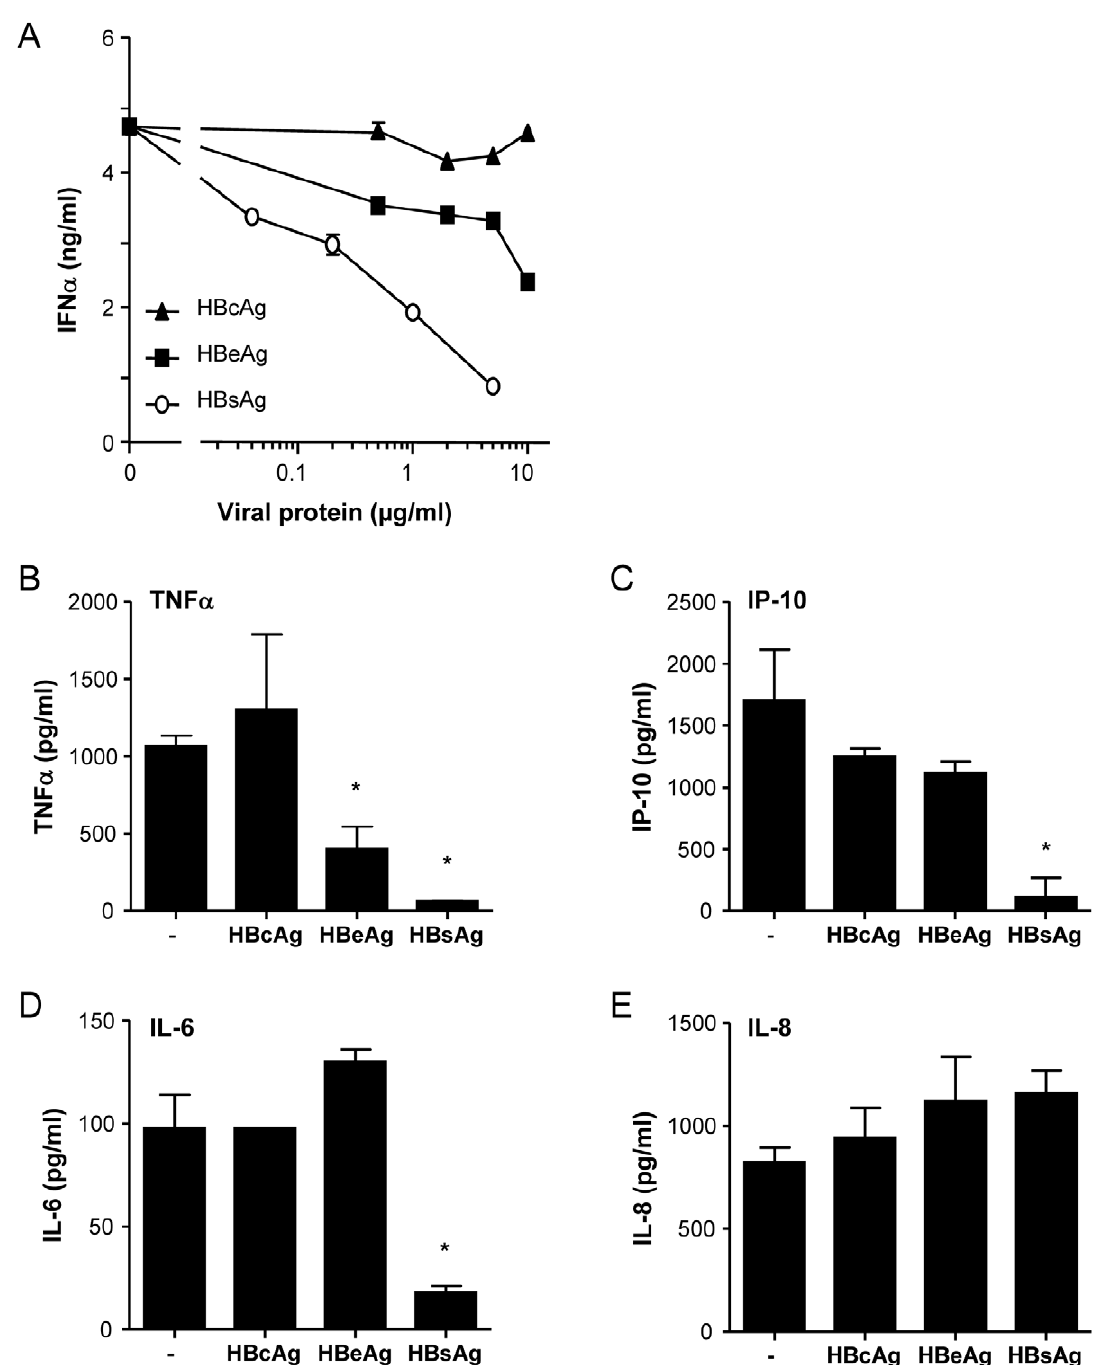
Figure 5. HBsAg and HBeAg inhibit cytokine production by pDC. pDC were cultured with CpG in the presence or absence of increasing doses or 5 m g/ml of HBcAg, HBeAg or HBsAg. Supernatants were harvested and analysed for IFN a (A), TNF a (B), IP-10 (C), IL-6 (D), and IL-8 (E). Data presented are mean 6 SEM of at least 8 independent experiments. *P , 0.05, Wilcoxon signed rank test compared to control.